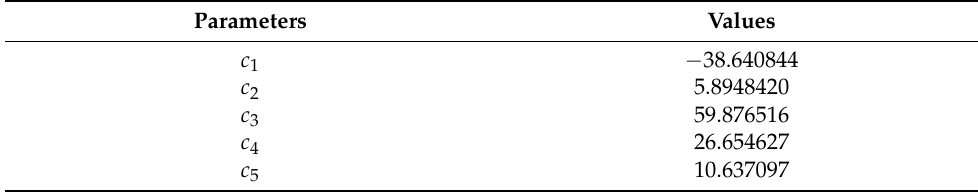
Table A1. Parameters of Equation